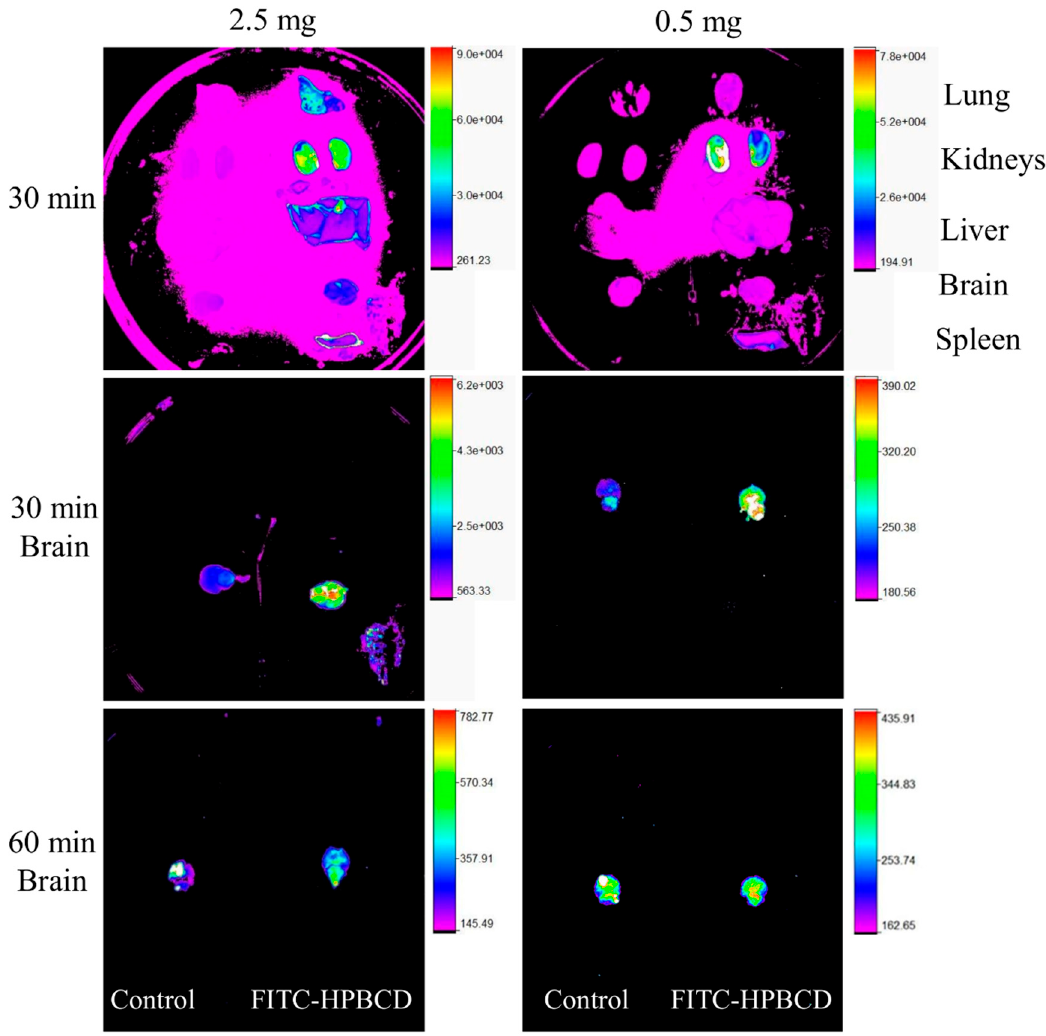
Figure 4. Representative ex vivo fluorescence images of the organs of FITC-HPBCD treated mice after 30 min treatment. Brains were examined separately from other organs after 30 and 60 min of treatment and imaged from beneath. The organs of untreated mice can be seen on the left in the images. Kidneys showed the highest fluorescence intensities in both doses (0.5 and 2.5 mg). In the case of 2.5 mg dose, lung also had elevated intensity. At 30 min the brains of the FITC-HPBCD treated animals had higher fluorescence than the controls, while after 60 min there was no difference between the fluorescence of the brains.